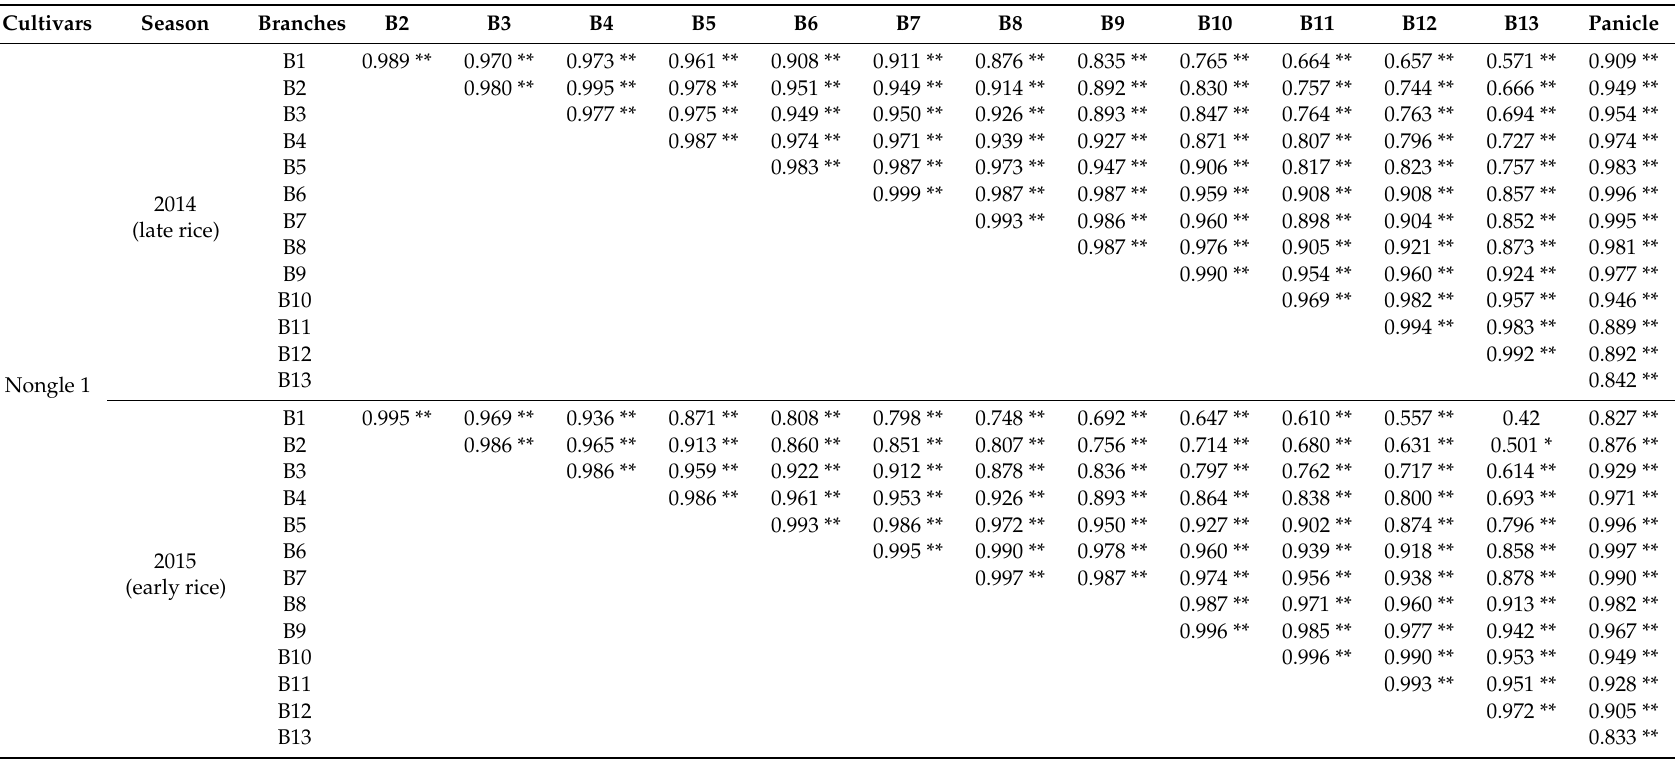
Table 2. The correlation coe ffi cients of dry-matter accumulation between primary-branch grains and the whole panicle of Nongle 1 in 2014 and 2015. B1 to B14 represent the 1st primary-branch grains to the 14th primary-branch grains from the top to the base of the panicle for Nongle 1 and Guifeng 2. Panicle indicates the whole panicle of Nongle 1. *, significance at the 0.05 probability level; **, significance at the 0.01 probability